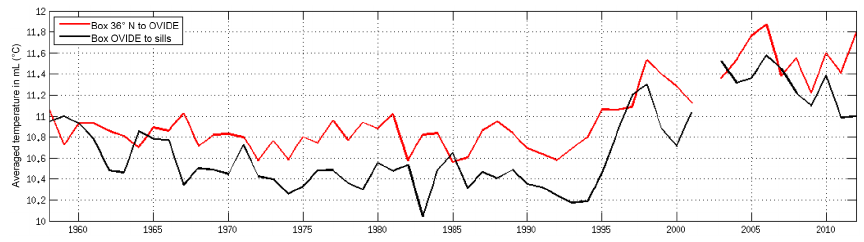
Figure 15. Annual time series of the average temperature of the mixed layer for Box 2 (36 ◦ N–OVIDE; red line) and Box 3 (OVIDE–sills; black line) as simulated by the model over the period